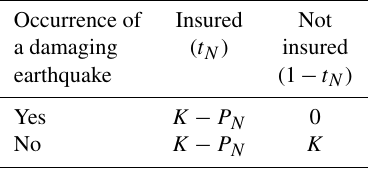
Figure 4. Fit between the take-up rates modelled and observed for the period